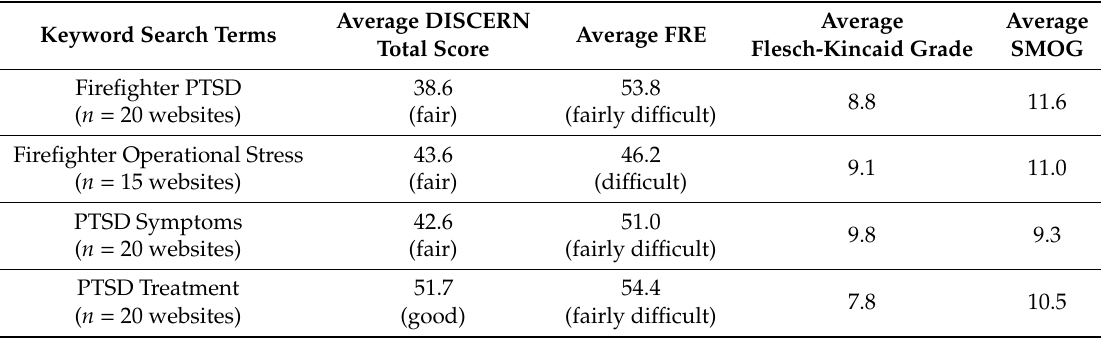
Table 1. The average readability statistics and DISCERN scores for the websites are generated from each of the keyword search terms. The average DISCERN total scores are out of a total possible score of 75, with higher scores representing better quality websites. The average Flesch reading ease (FRE) scores are out of a total possible score of 100, with higher scores being simpler to read. The average Flesch-Kincaid Grade and average Simple Measure of Gobbledygook (SMOG) levels represent school grade levels, with lower grades being simpler to read and